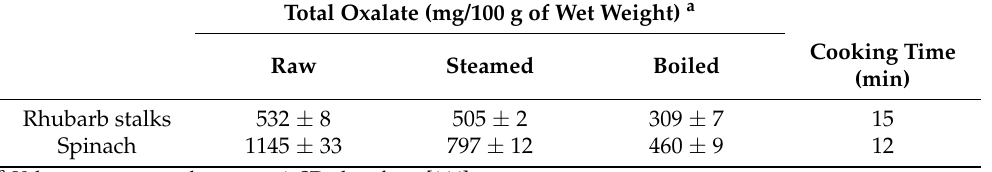
Table 7. Influence of steaming and boiling on the total oxalate (soluble and insoluble) content in spinach and